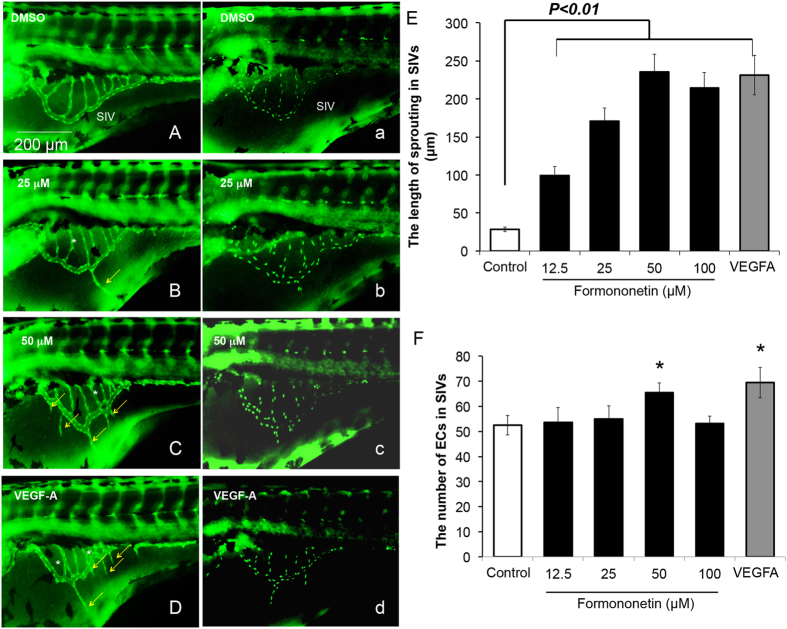
The effects of formononetin on angiogenic sprouting in the SIVs of Tg (fli1: EGFP)y1 and Tg (fli1: nEGFP)y7 zebrafish embryos.(A,a) Tg (fli1: EGFP)y1 and Tg (fli1: nEGFP)y7 zebrafish embryos (48 hpf) were treated with 0.1% DMSO for 24 h to serve as negative control. The SIVs of zebrafish embryos at 72 hpf developed into a smooth basket-like structure. Zebrafish embryos (48 hpf) treated with formononetin for 24 h at (B,b) 25 μM or (C,c) 50 μM showed that there was an increase of sprouting in the subintestinal vessels (SIVs) baskets stretching into the posterior yolk extension. (D,d) Zebrafish embryos were injected with zebrafish VEGF-A (ZF-VEGF-A) (1 ng/embryo) at 1 hpf and incubated in embryo medium until 72 hpf to serve as positive control. Yellow arrows indicated sprouting vessel formation; white asterisks indicated intersection branch formation. Statistical analysis showed that formononetin increased (E) the length of vascular sprouting in the SIVs and (F) the number of endothelial cells in the SIVs in a dose-dependent manner. The number of endothelial cells was measured using Image J software package. Data are plotted as mean ± SD, (n > 3), *p < 0.05, **p < 0.01 vs. control.